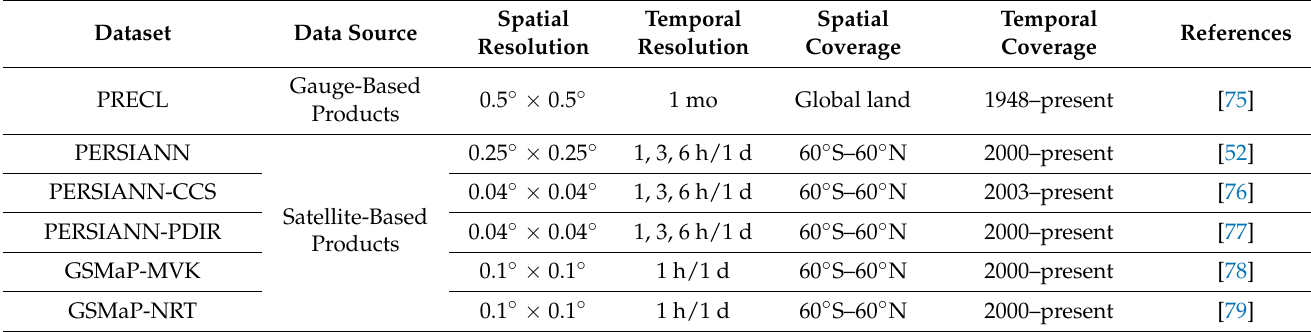
Table 1. Details of used existing precipitation products in this